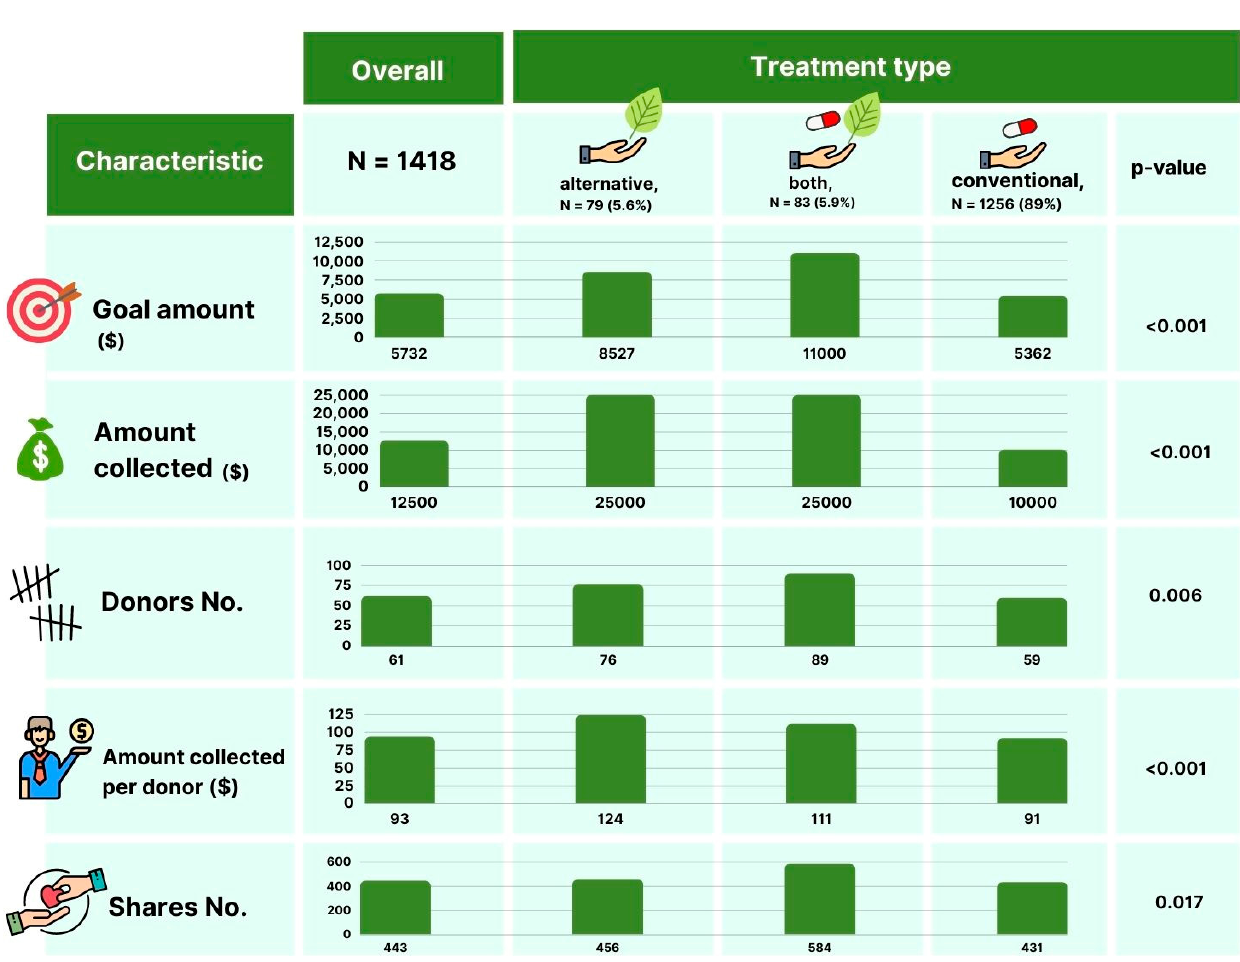
Figure 2. Selected figures of 1418 GoFundMe.com online crowdfunding campaigns fundraising for urologic malignancies stratified by treatment type. Table 2. Characteristics of 1418 GoFundMe.com online crowdfunding campaigns fundraising for urologic malignancies stratified by treatment type.